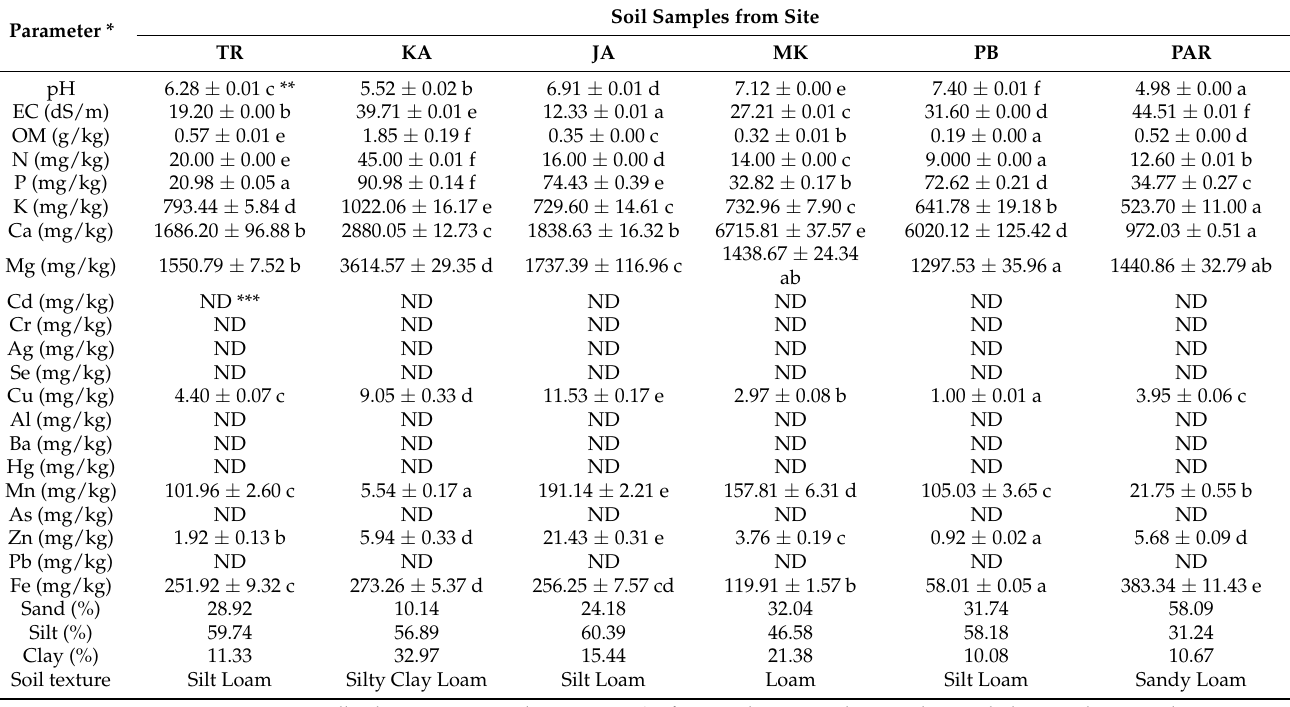
Table 2. Mangrove soil physicochemical properties of each sampling